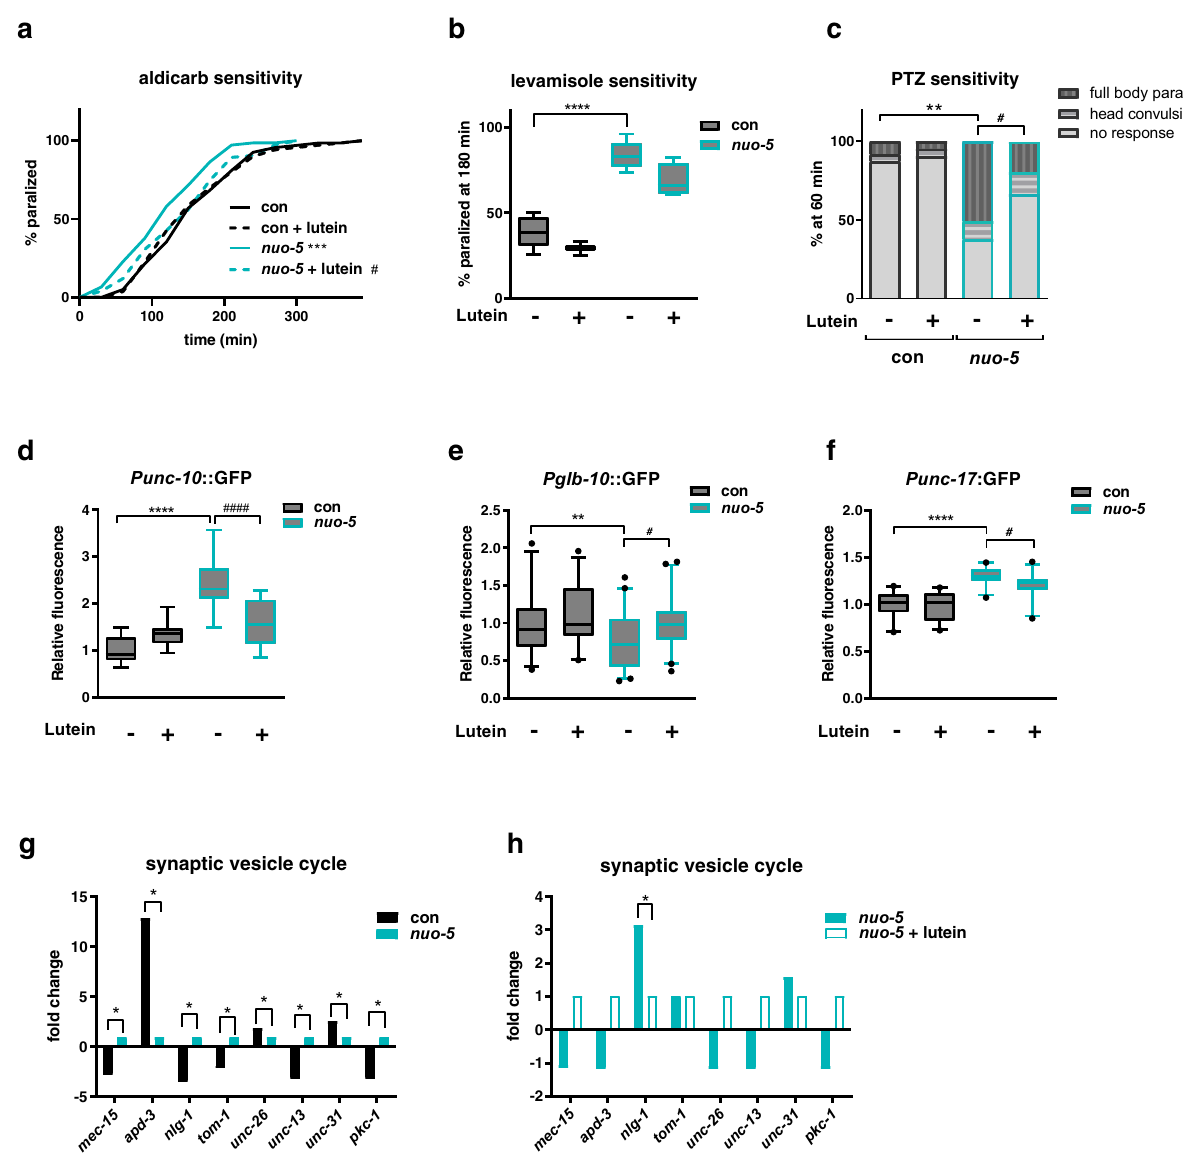
Fig. 6 Lutein suppresses an nlg-1 -dependent synaptic defect in nuo-5 -depleted animals. Worms in all panels were fed bacteria transformed either with empty-vector (con, black bars) or with vector expressing dsRNA against nuo-5 (light blue bars) and left untreated or treated with 1 µ M Lutein. a Aldicarb- induced paralysis curves on plates containing 0.5 mM aldicarb. Log-rank test: con vs nuo-5 p = 0.0004, nuo-5 vs nuo-5 + lutein p = 0.018. n ≥ 75 over three biologically independent experiments. b Percentage of animals paralyzed on plates containing 50 µ M Levamisole. Box plots indicate median (middle line), 25th, 75th percentile (box) and 5th and 95th percentile (whiskers) as well as outliers (single points). n ≥ 60 over four biologically independent experiments. con vs nuo-5 p < 0.0001. c Bars indicate percentage of animals with the indicated phenotypes after 1 h of exposure to 2.5 mg/ml PTZ. n = 60 over four biologically independent experiments. Asterisks denote the differences only of the full body-paralysis phenotype. con vs nuo-5 p = 0.0085 , nuo- 5 + lutein p = 0.046. d – f Quanti fi cation of GFP expression in the indicated transgenic strains. Box plots indicate median (middle line), 25th, 75th percentile (box) and 5th and 95th percentile (whiskers) as well as outliers (single points). n ≥ 45 over three biologically independent experiments. Asterisks (*) denote signi fi cant differences vs control, # denote differences among conditions. p values in d : **** p values < 0.0001, p < 0.0001. p values in e : con vs nuo- 5 p = 0.0066, nuo-5 vs nuo-5 + lutein p = 0.0112. p values in f : con vs nuo-5 p < 0.0001, nuo-5 vs nuo-5 + lutein p = 0.0474. Two-way ANOVA followed by Tukey ’ s multiple-comparisons test, unless otherwise speci fi ed. Data for all panels are provided as a Source Data fi le. g , h Fold change of genes involved in synaptic vesicle cycle expression (from microarray